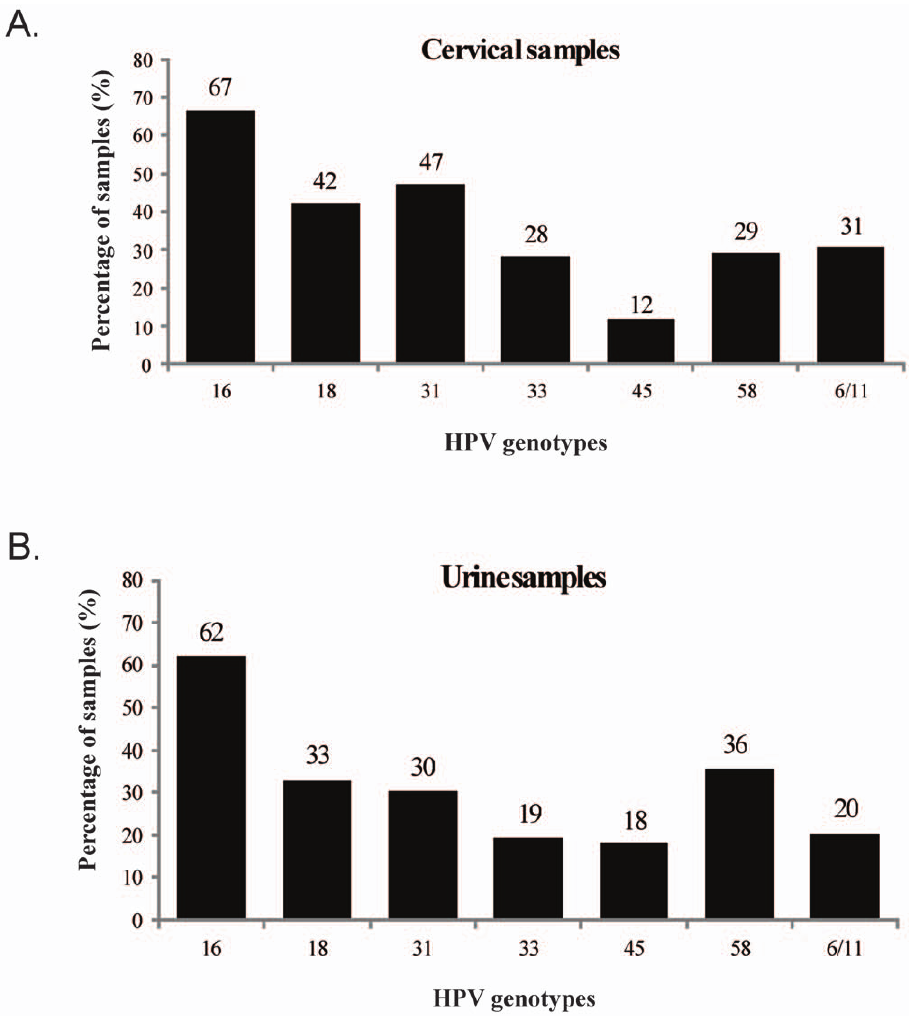
Figure 1. Prevalence of HPV types in cervical and urine samples for 204 HIV-infected Colombian women.